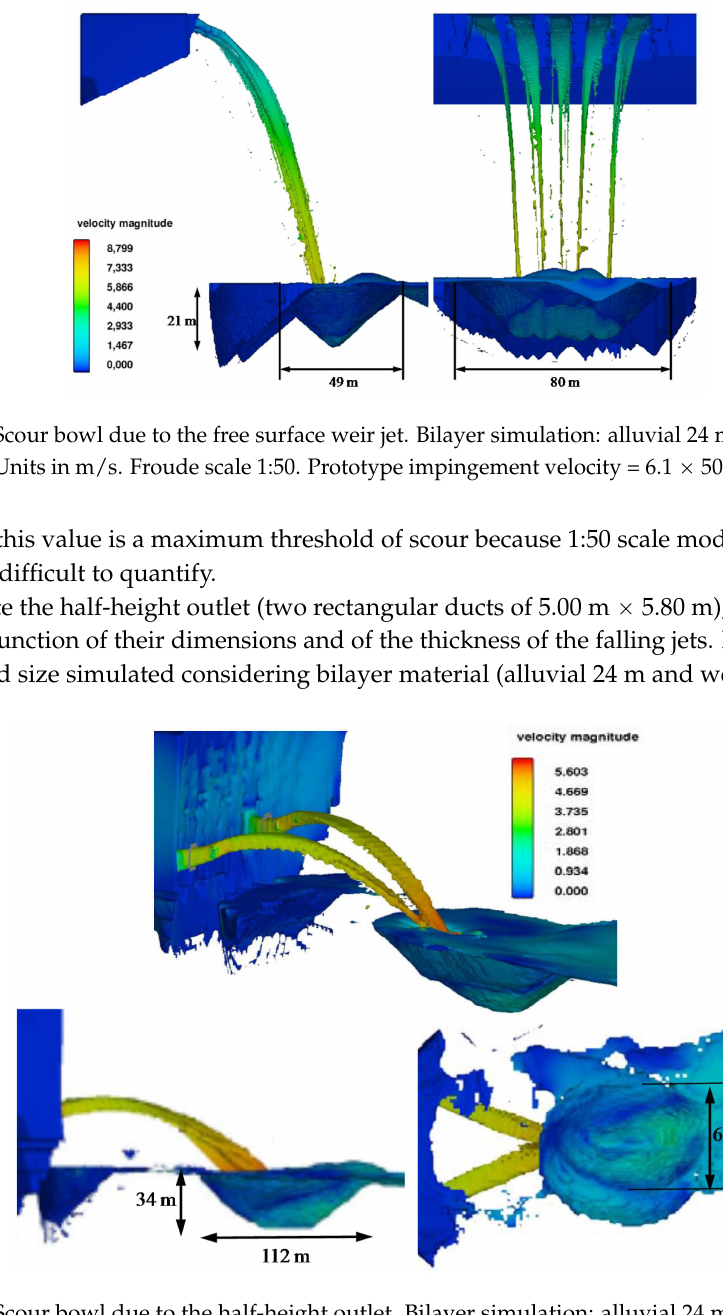
Figure 12. Scour bowl due to the half-height outlet. Bilayer simulation: alluvial 24 m and weathered rock 10 m. (Units in m/s. Froude scale 1:50. Prototype impingement velocity = 5.4 ˆ 50 1/2 = 38.18